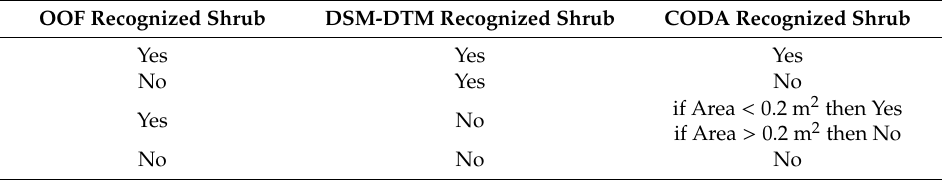
Table 2. Combination reference table of shrub areas identified by OOF and DSM-DTM.